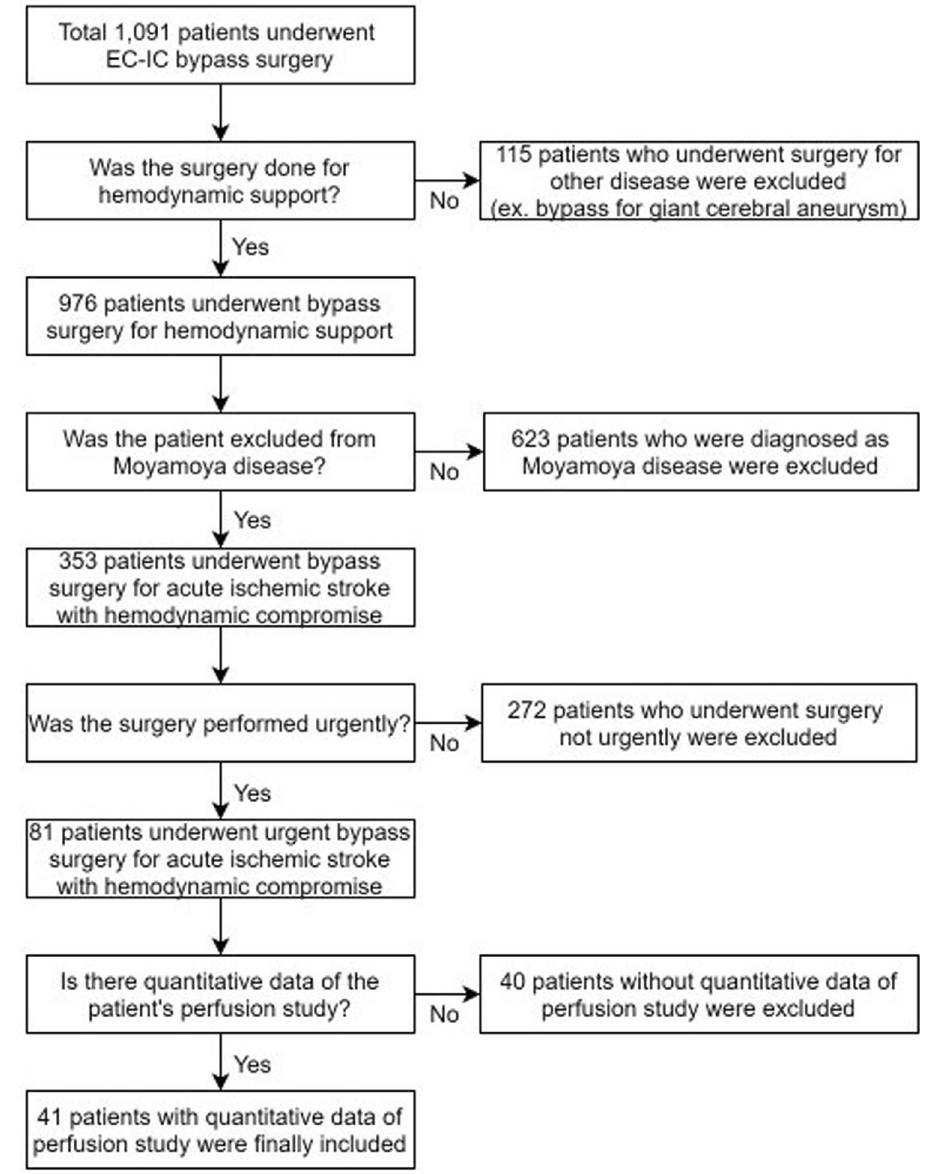
Figure 1. Flow diagram of the enrolled